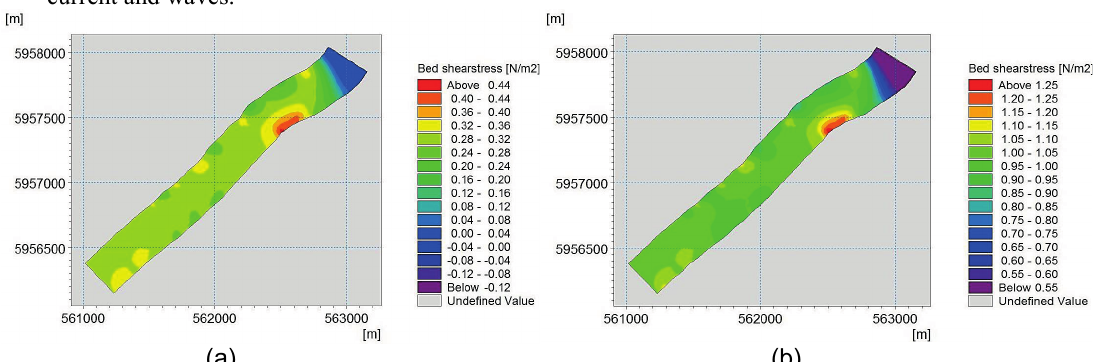
(a) (b) Fig. 9 Max event shear stresses in the 2-Mile channel due: (a) to currents (b) to a combination of current and